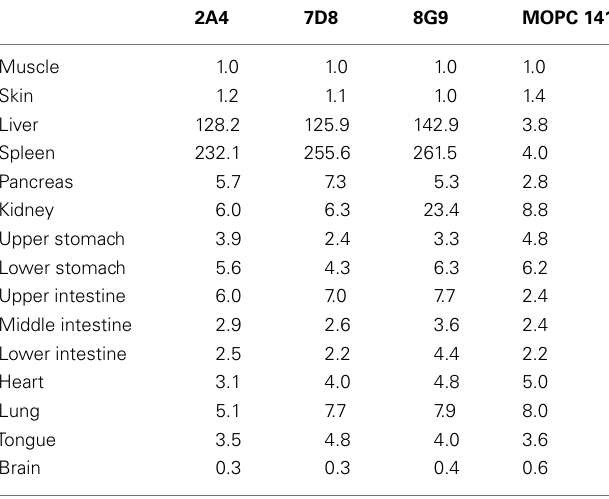
Table 3 |Tissue:muscle ratios for mice withAA amyloidosis injected with 125 I-labeled anti-AA or control